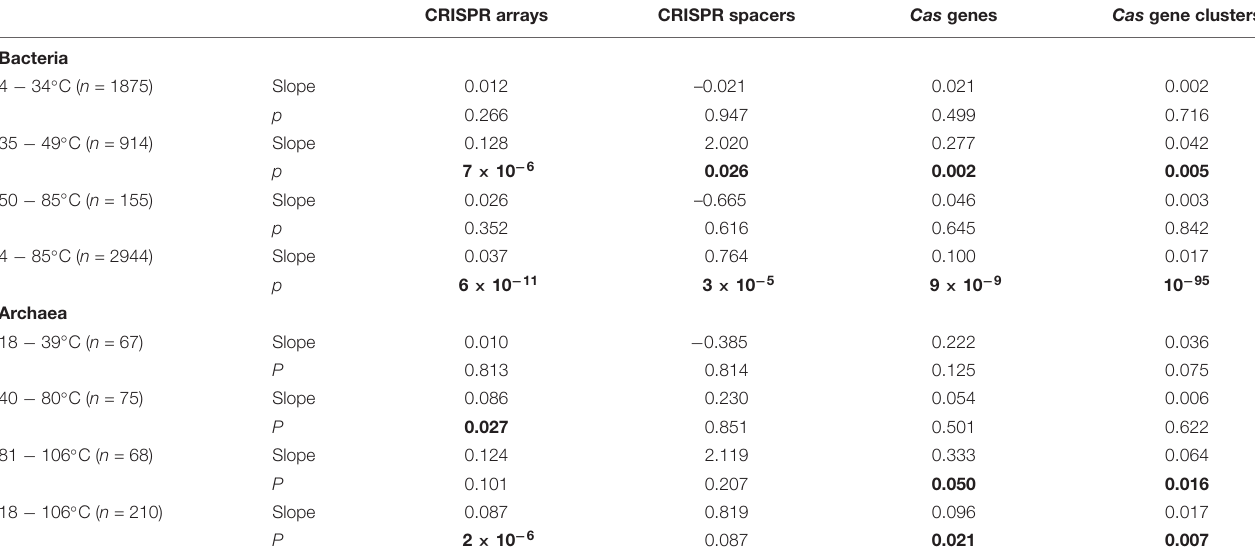
TABLE 1 | Correlations between bacterial CRISPR-Cas abundance and optimal growth temperature.